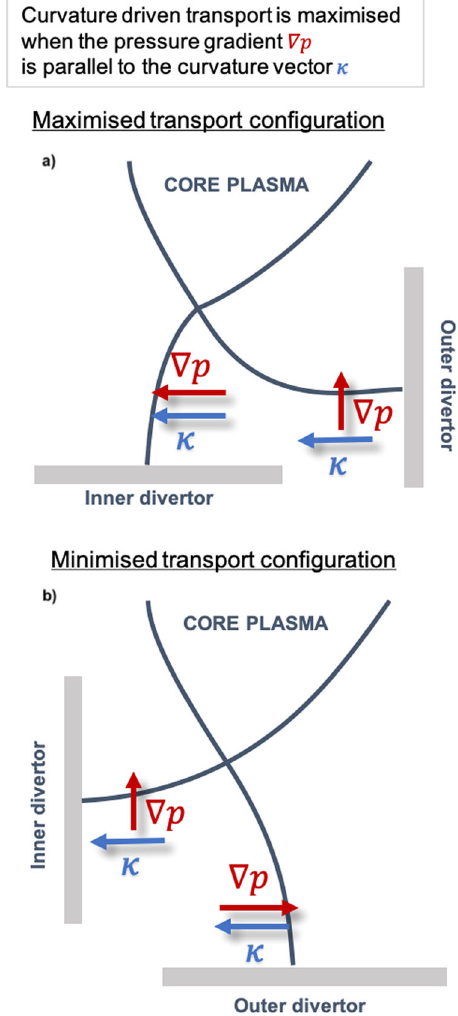
Fig. 7 Schematic illustration of the impact of divertor geometry on turbulence levels. Con fi gurations showing proposed divertor geometry con fi gurations that maximise ( a ) and minimise ( b ) turbulent transport from the scrape-off layer (SOL) into the private fl ux region (PFR) due to the alignment/misalignment of the pressure gradient in the PFR and the magnetic curvature vector. ∇ P is the gradient of the electron pressure and κ is the magnetic curvature